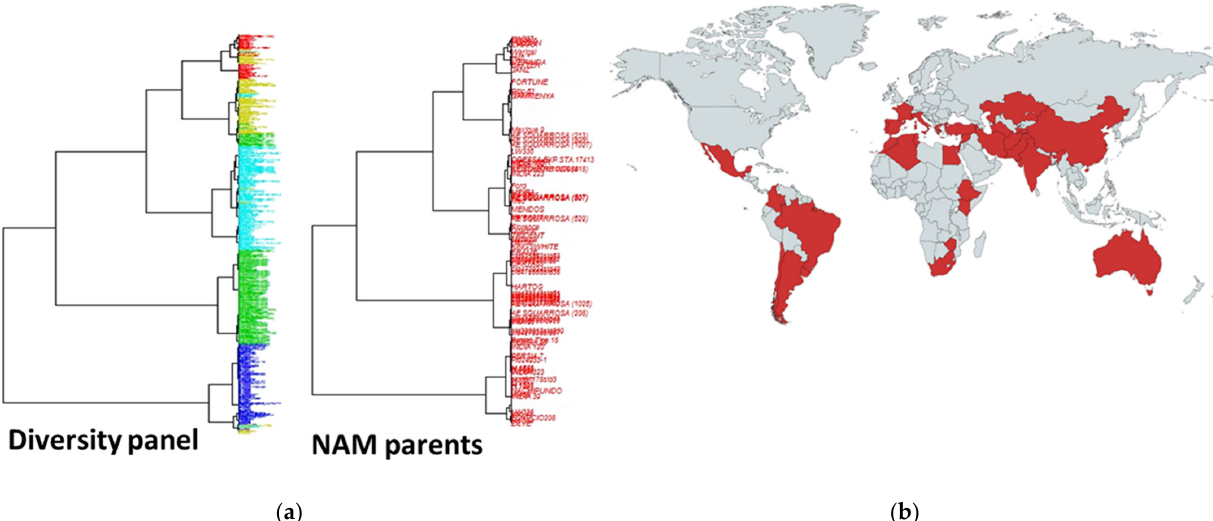
Figure 5. Characteristics of the NAM exotic parents ( a ) Phylogenic trees showing diversity in the diversity panel from which the diverse exotic parents were selected. The NAM parents are highlighted from the phylogenic tree; ( b ) geographical distribution of the NAM exotic